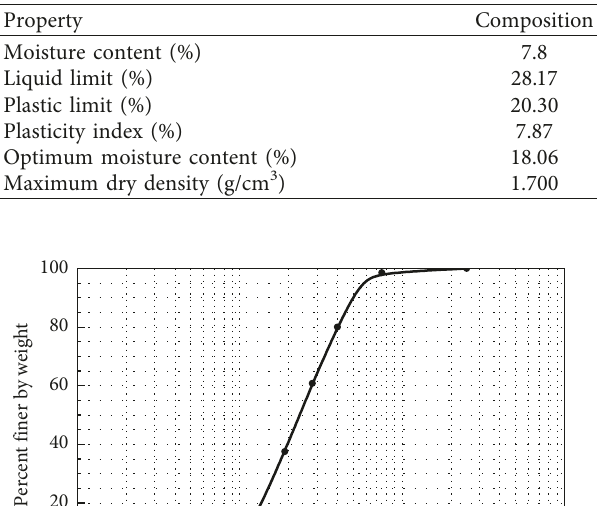
Table 1: Physical and mechanical properties of loess used in the tests.